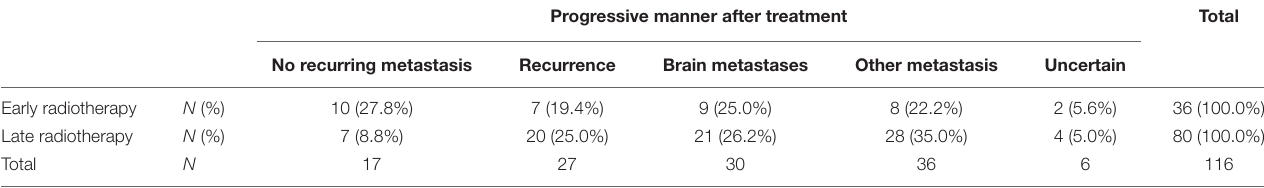
TABLE 2 | The influence of radiotherapy intervening time on the progressive manner after treatment.